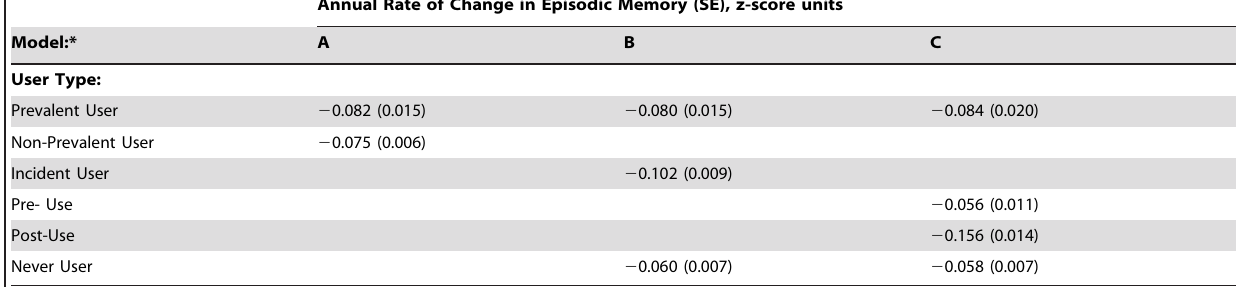
Annual Rate of Change in Episodic Memory (SE), z-score